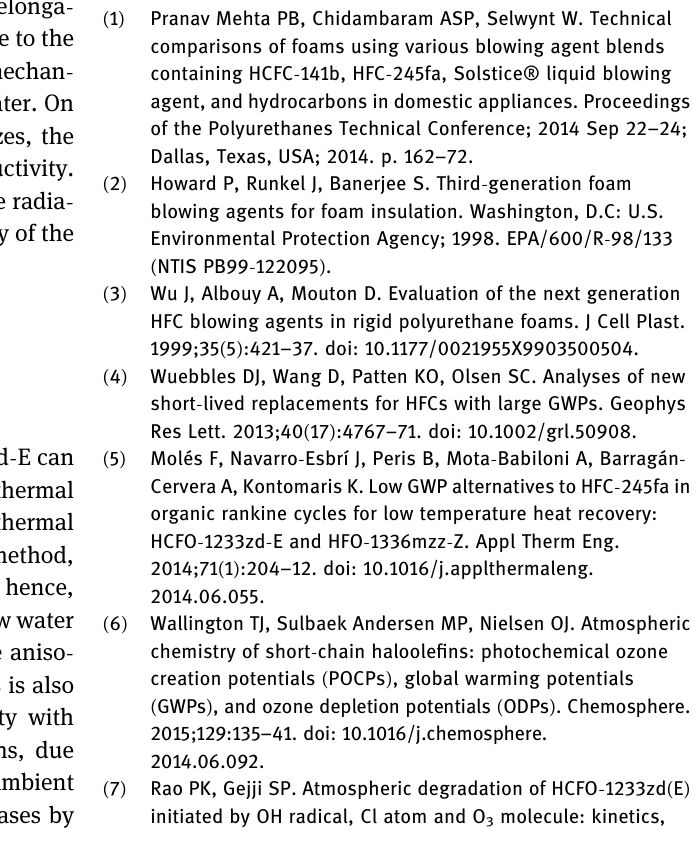
Table 4. The average values of the cells ’ length and width were calculated from the measurements of 100 cells. But